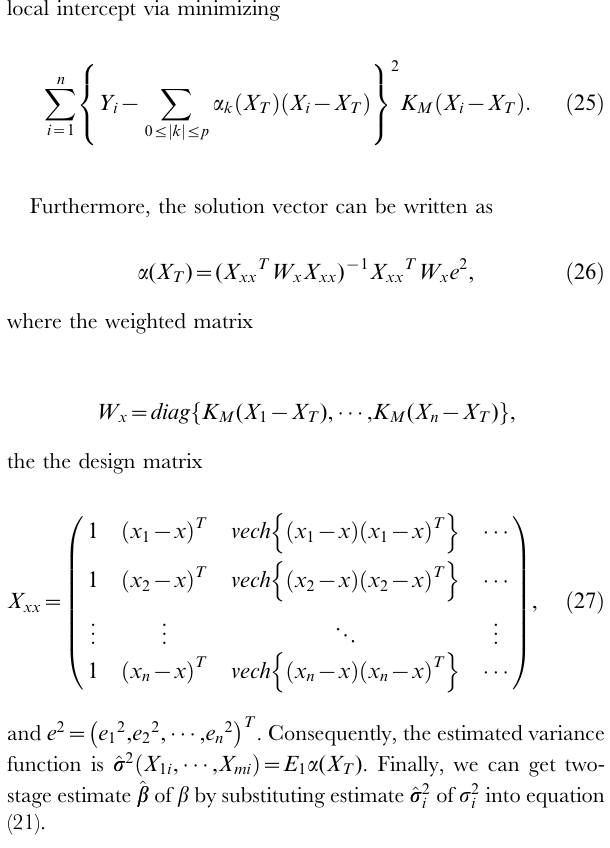
Figure 32. Scatter of original and fitting data. the p -order local polynomial estimate of the variances function s 2 x 1 i , (cid:2)(cid:2)(cid:2) , x mi ð Þ is according to formula (2). Using the least squares method for the data around the local window, we can estimate the local intercept via minimizing